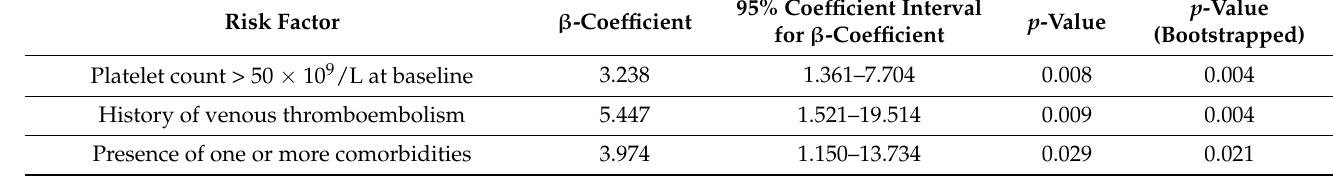
Table 3. Logistic regression model for occurrence of venous thromboembolism within 45 days from acute myeloid leukemia diagnosis.